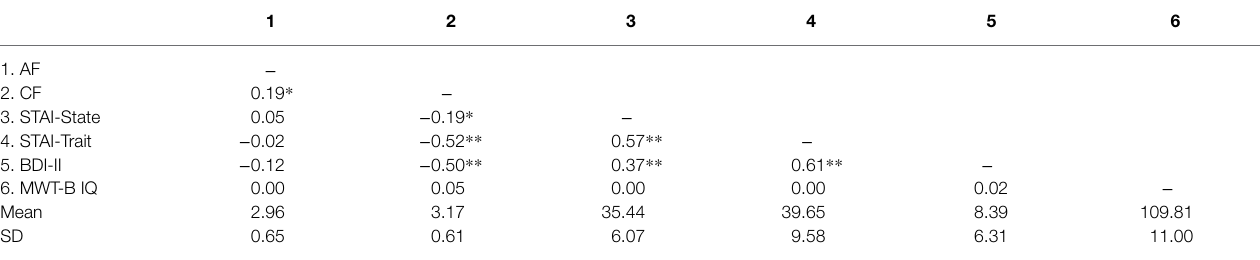
TABLE 1 | Descriptive statistics and product–moment correlations between psychological measures ( N = 118).